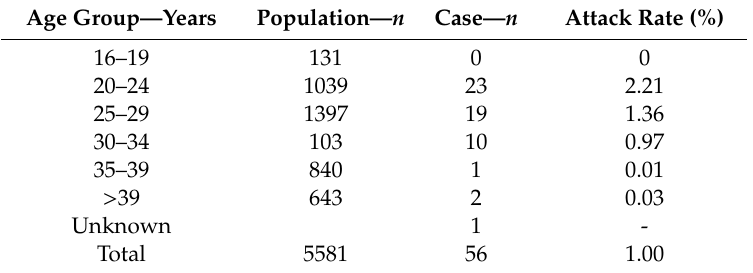
Table 2. Number of total population, cases and attack rate by age groups in Factory-S and